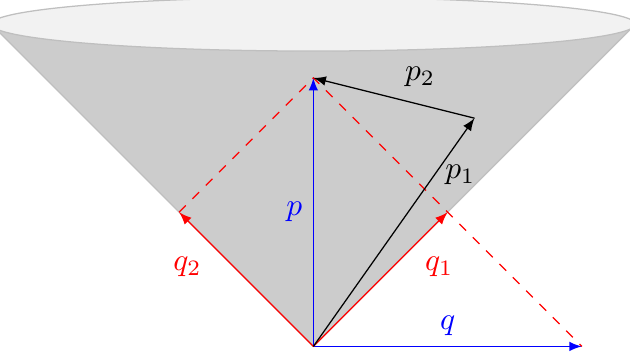
Figure 1 . Given a pair of momenta p 1 and p 2 that add up to p inside the forward light cone, shown here in the center-of-mass frame ( p = 0 ), one can always define two null momenta q 1 and q 2 that are the projections of p onto the light cone in the plane spanned by p 1 and p 2 . The space-like vector q = q 1 − q 2 satisfies p · q = 0 and q 2 = − p 2